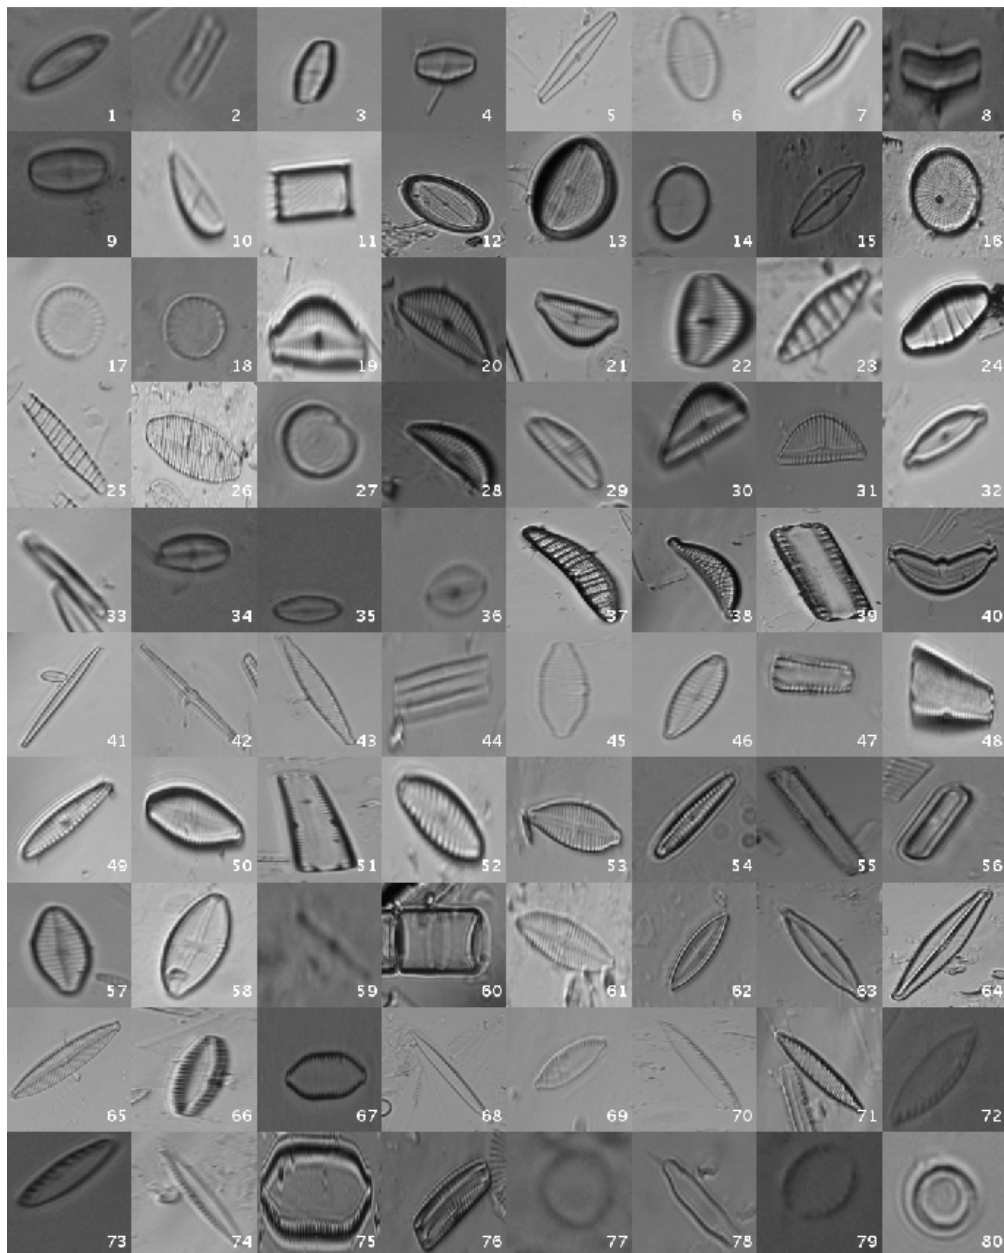
Figure 1. Examples of diatom classes in the original